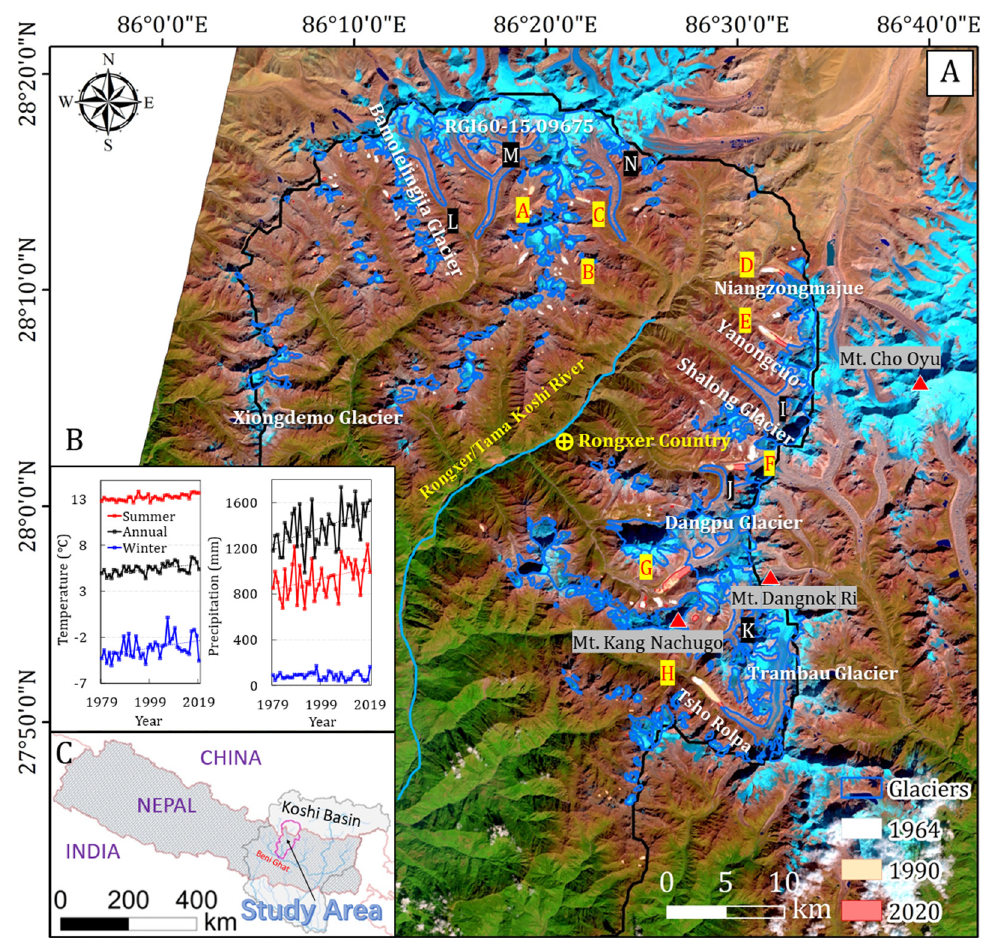
Figure 1. ( A ) Distribution of glaciers and glacial lakes in the Tama Koshi basin with the background image of Landsat 8 (24 October 2018), letters indicate detailly investigated glaciers and glacial lakes. The inset ( B ) shows the mean annual (red), summer (blue), and winter (black) air temperature ( left ) and precipitation ( right ) extracted from ERA5. The inset ( C ) indicates the location of the study area.